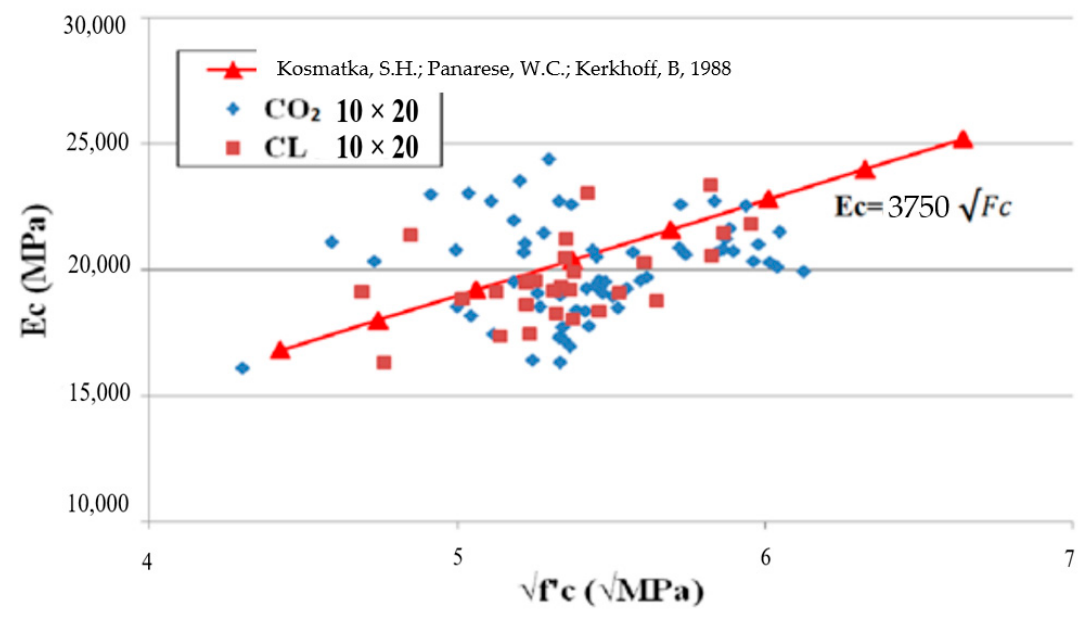
Figure 8. Relationship between elastic modulus and square root of strength obtained from 10 × 20 cm cylinders. Partialy adapted from Ref. [42].